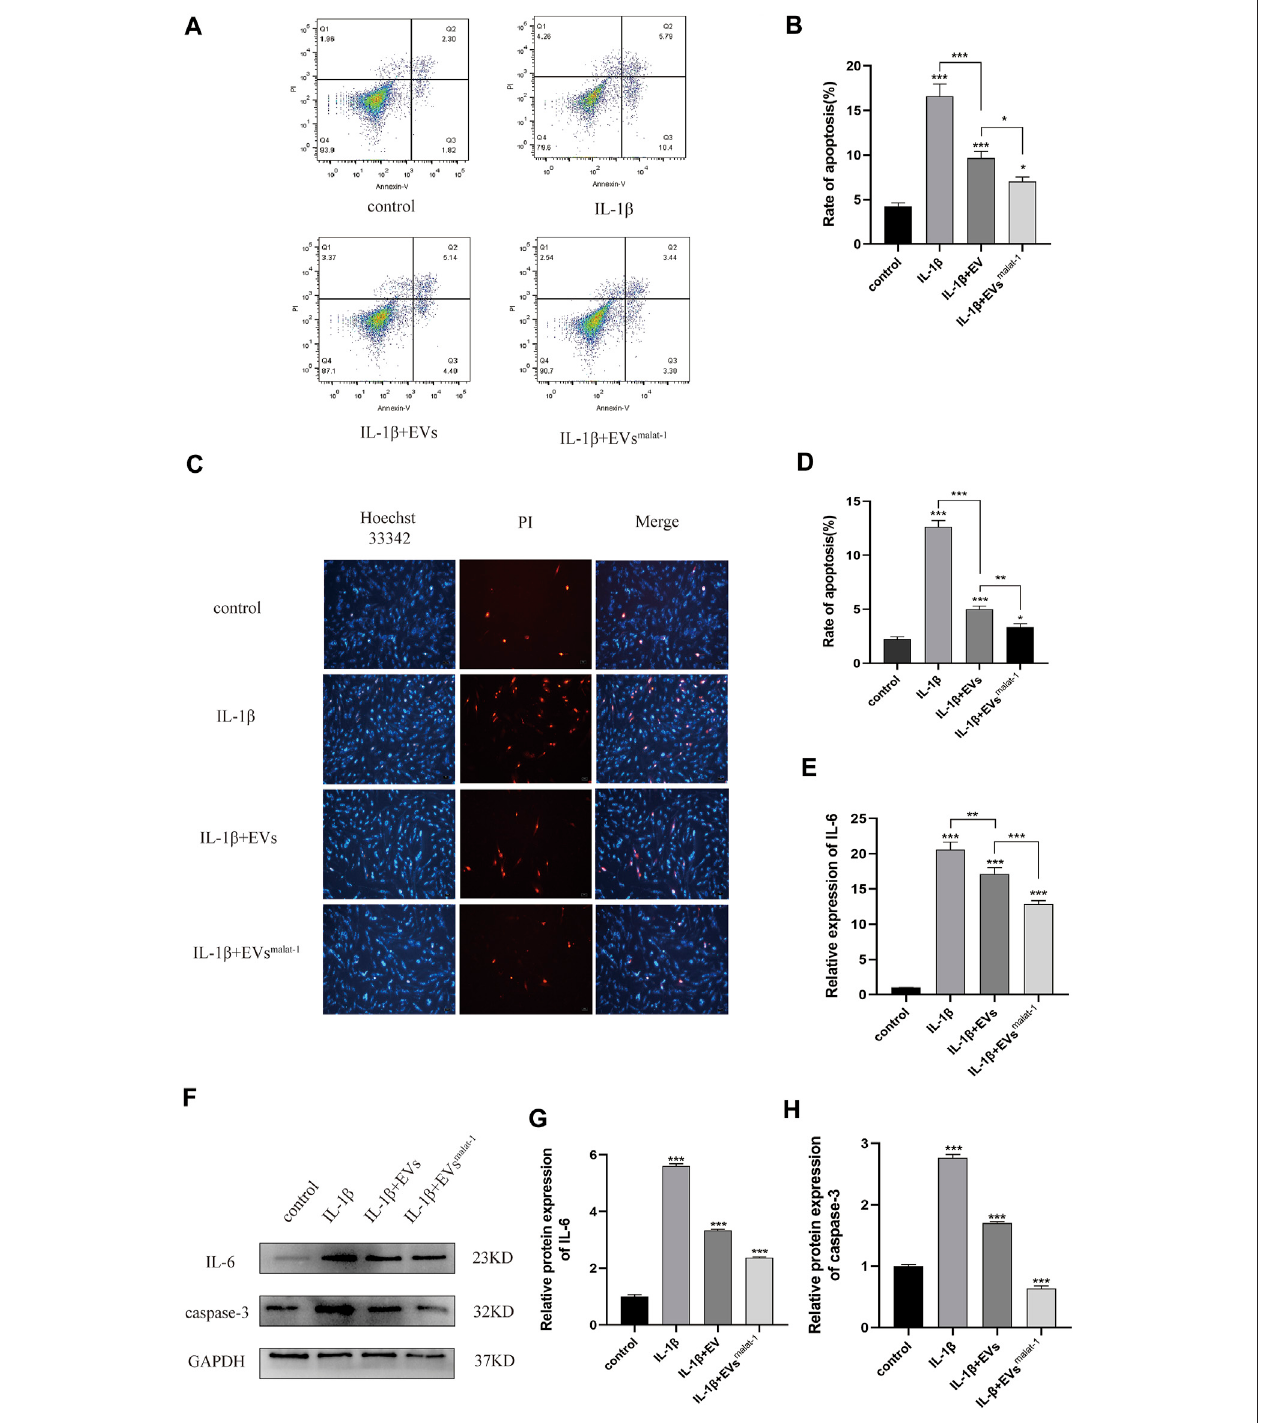
FIGURE 4 | (A) and (B) The apoptosis rate of chondrocytes treated with EVs analyzed by fl ow cytometry assay. (C) and (D) Hoechst 33342/PI assay was used to analyze theapoptosis rate ofchondrocytes. (E) In fl ammatory factor IL-6 expression was measured using Elisain chondrocytes after treated withEVs. (F – H) The protein expression of IL-6 and Caspase-3 analyzed by western blot. * p < 0.05, ** p < 0.01, *** p < 0.001, vs. control group. n (cid:2) 3, one-way ANOVA for all. higher than that from the normal group (4.25 ± 0.32%, p < 0.05). cytometry. As the result show ( Figures 4A,B ), the apoptosis rate After treatment with the hMSCs-EVs, the apoptosis rate of of the IL-1 β group (16.62 ± 1.12%, p < 0.05) was signi fi cantly chondrocytes (9.67 ± 0.6%, p < 0.05) decreased by a third. At